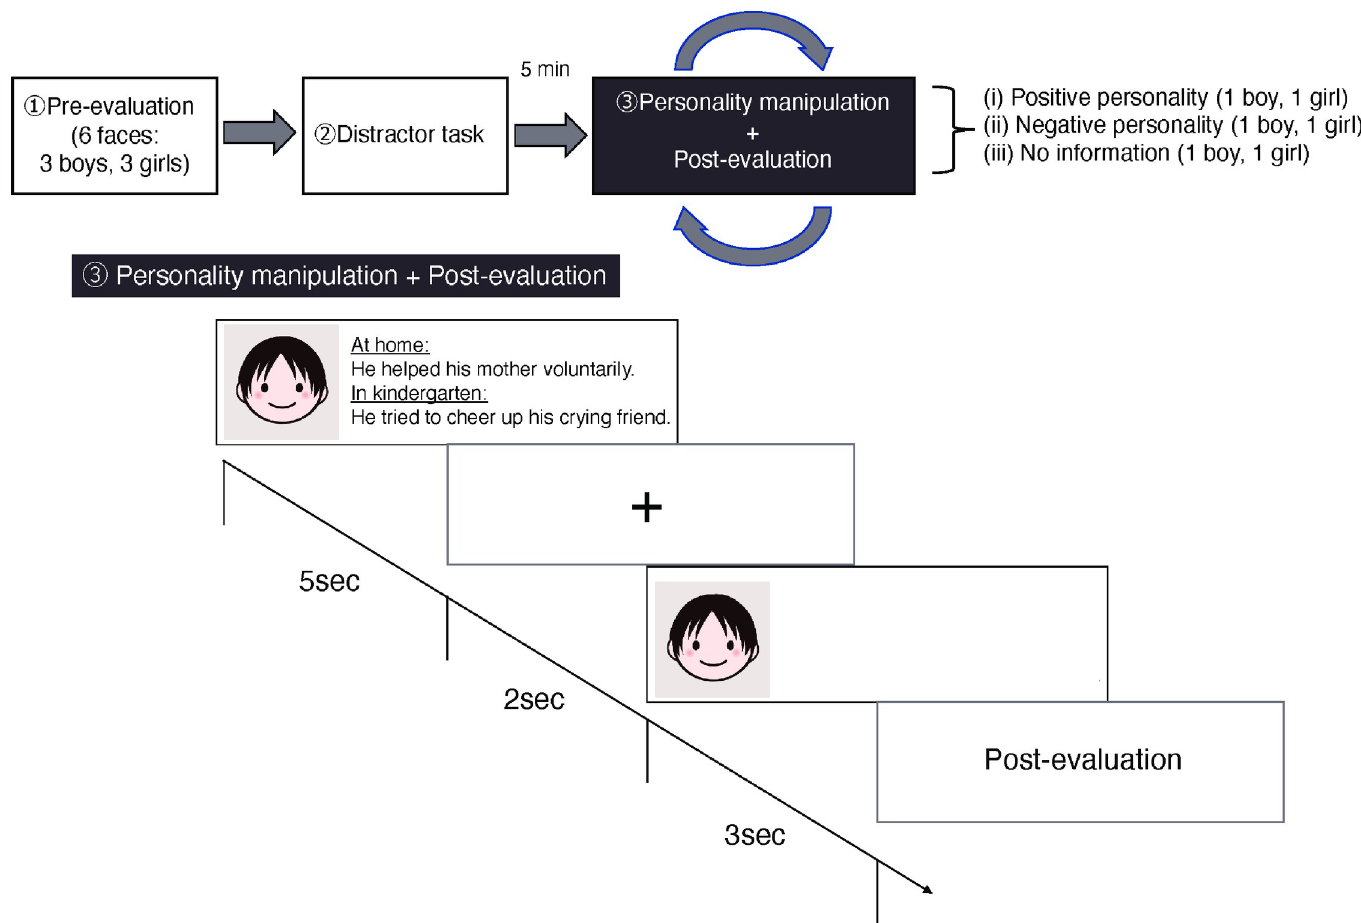
Fig 1. Experimental procedure. The personality description here is an example of positive personality